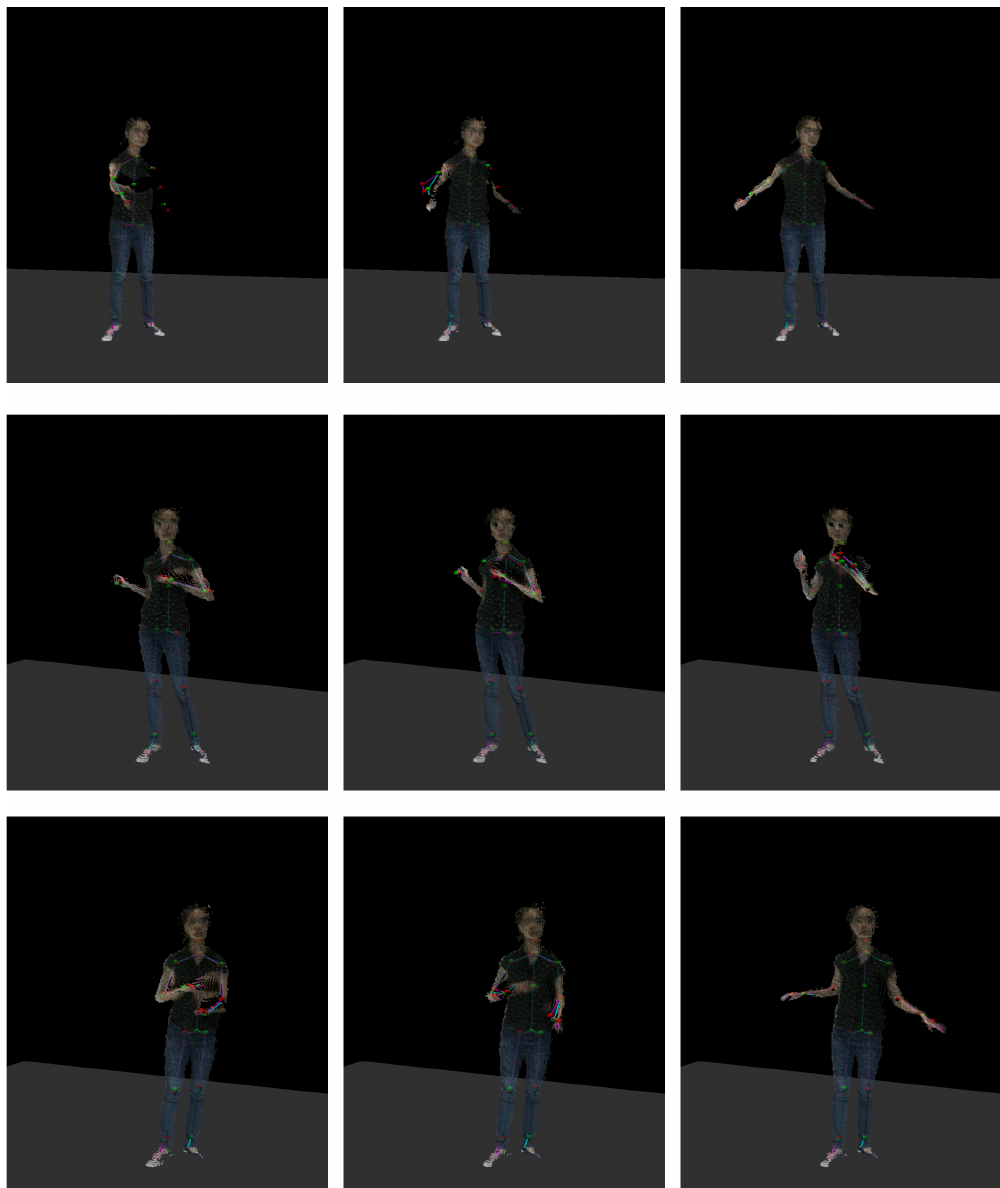
Figure 17. Each row shows three frames in a motion clip. The initial skeleton observed by the Kinect SDK [1] is colored in magenta, and the cyan one is the updated result from our